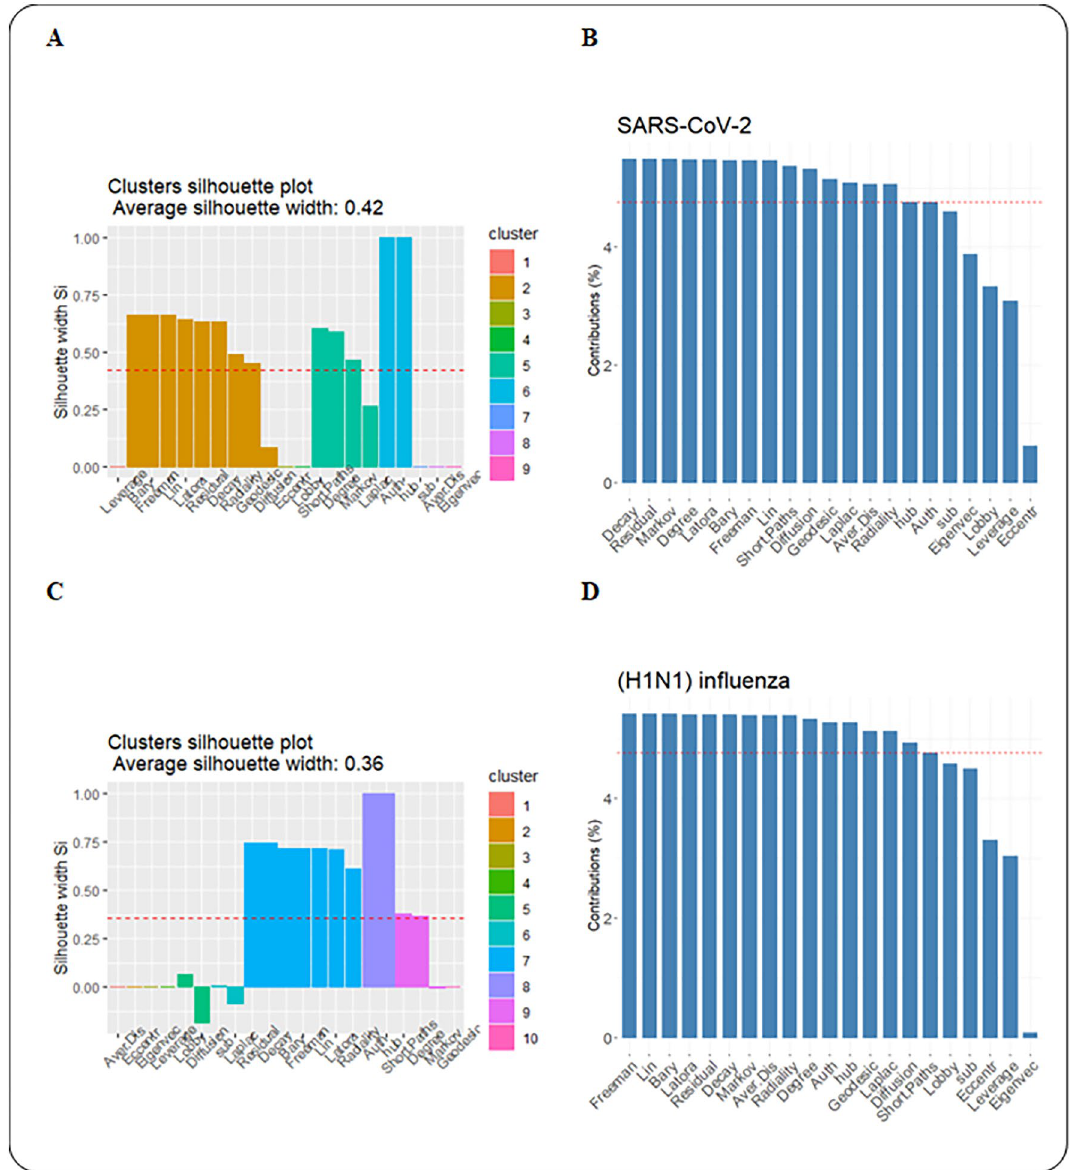
Figure 7. ( A ) Clustering silhouette plot of the combined-score PPIN. The colors represented the nine clusters of the centrality measures in SARS-CoV-2 PPIN. The average silhouette width was 0.42. ( B ) Contribution values of centrality measures according to their corresponding principal components in SARS-CoV-2 PPIN. ( C ) Clustering silhouette plot of the combined-score PPIN. The colors represented the ten clusters of the centrality measures in (H1N1) influenza. The average silhouette width was 0.36. ( D ) Contribution values of centrality measures according to their corresponding principal components in (H1N1) influenza